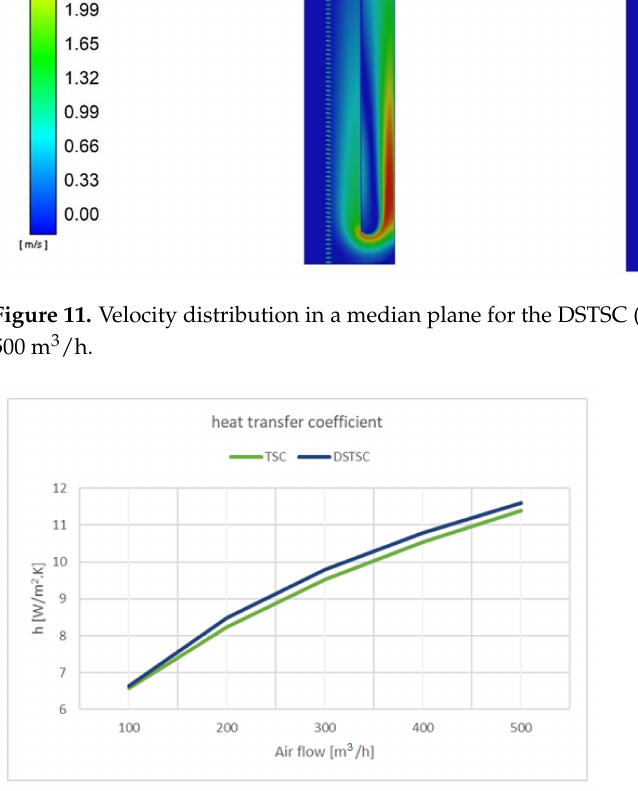
Figure 12. Computed results on the evolution of the heat transfer coefficient for the TSC and DSTSC.